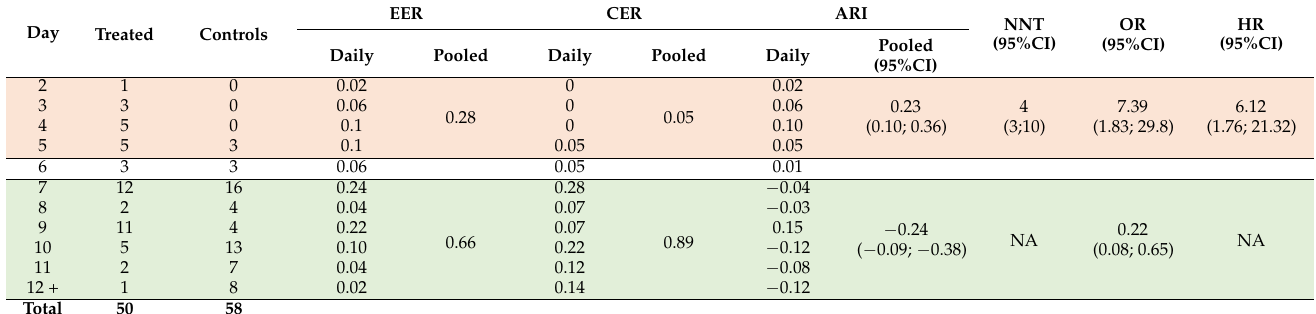
Table 3. Number of negative antigenic swab test results (=study endpoint) in treatment versus control arm, by number of days since initial positive RT-PCR swab test for SARS-CoV-2; proportion of endpoint in the experimental (experimental event rate (EER)) and control (control event rate (CER)) group; absolute risk increase (ARI), computed as difference between EER and CER since treatment increases the risk of endpoint. NNT = number needed to treat. Rate of events in the experimental (EER) and control (CER) arm, by two time blocks (days 1–5 versus days 7–15) with estimates and 95% confidence intervals (95%CIs) of four measures of clinical significance: absolute risk increase (ARI), number needed to treat (NNT), odds ratio (OR) and hazard ratio